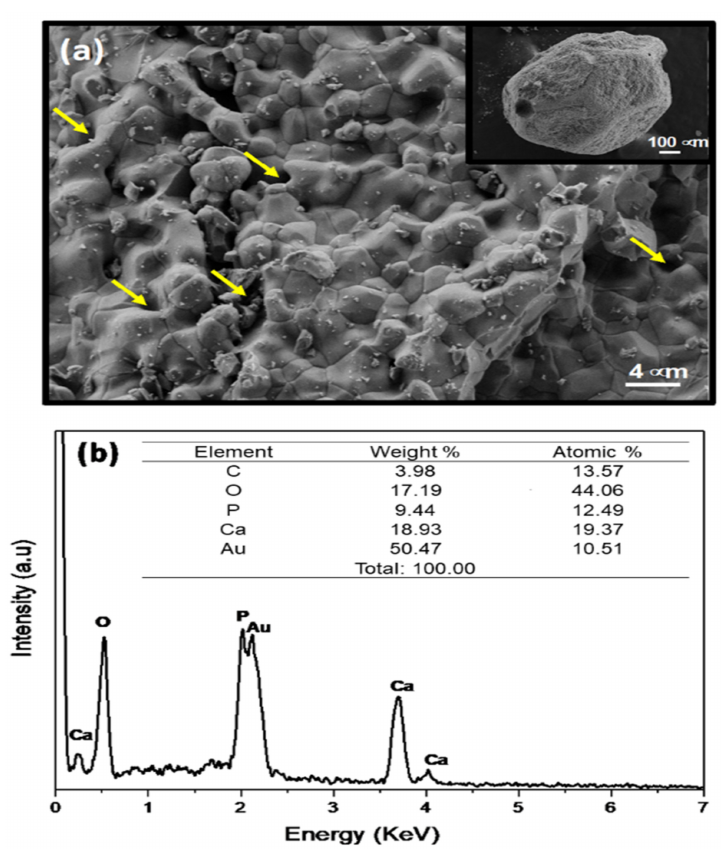
Figure 2. ( a ) FEG-SEM micrographs obtained for the BCP sample (yellow arrows shows porous structure). The inset reveals the aspect almost spherical particles. ( b ) EDS spectrum of the BCP sample.